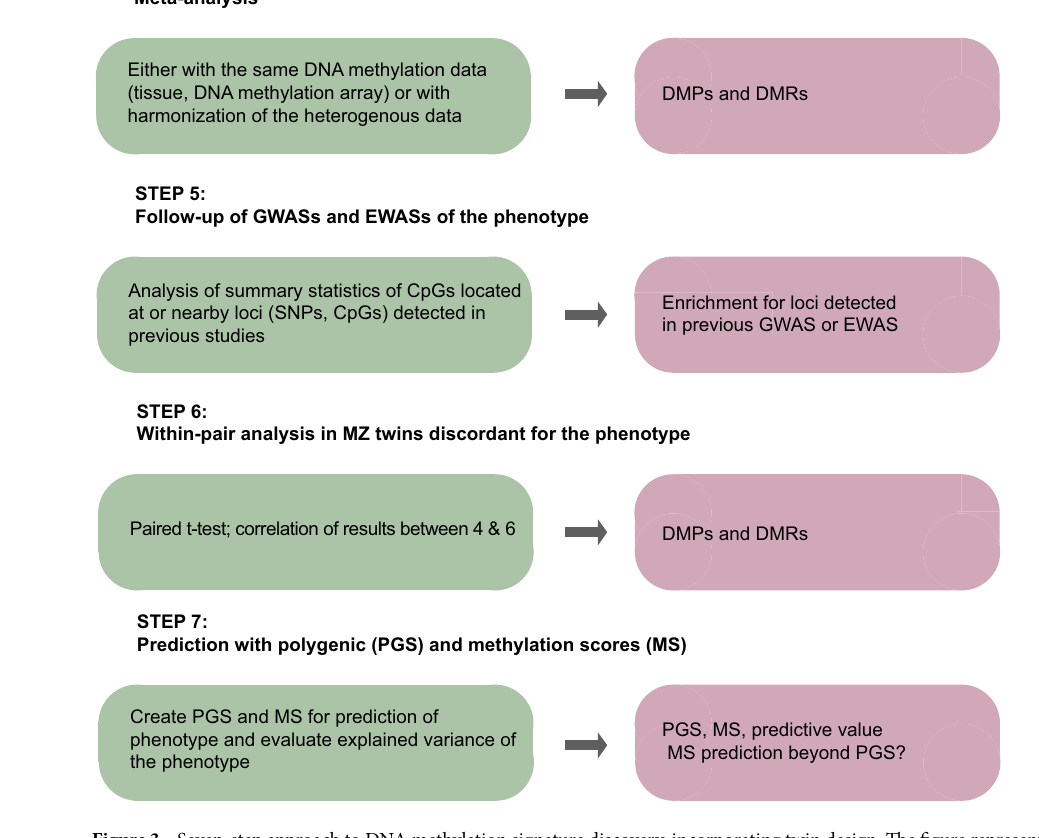
Figure 3. Seven-step approach to DNA methylation signature discovery, incorporating twin design. The figure represents the methodology of DNA methylation signature discovery study of a phenotype in multiple steps. It integrates behavioral-genetic and SNP-based methods (step 1) to estimate heritability, epigenome-wide study methods (steps 3–4) for association analyses, follow-up of results using summary statistics from previous EWASs and GWASs (step 5), the discordant twin design (step 6), and methods integrating polygenic and DNA methylation data (step 7) in enrichment analysis. Specific methods for each step are presented on the left and outcomes on the right. GWAS, genome-wide association study. EWAS, epigenome-wide association study. SNP, single nucleotide polymorphisms. CpG, cytosine-phosphate-guanine. PGS, polygenic scores. MS, methylation scores. DMPs, differentially methylated positions. DMRs, differentially methylated